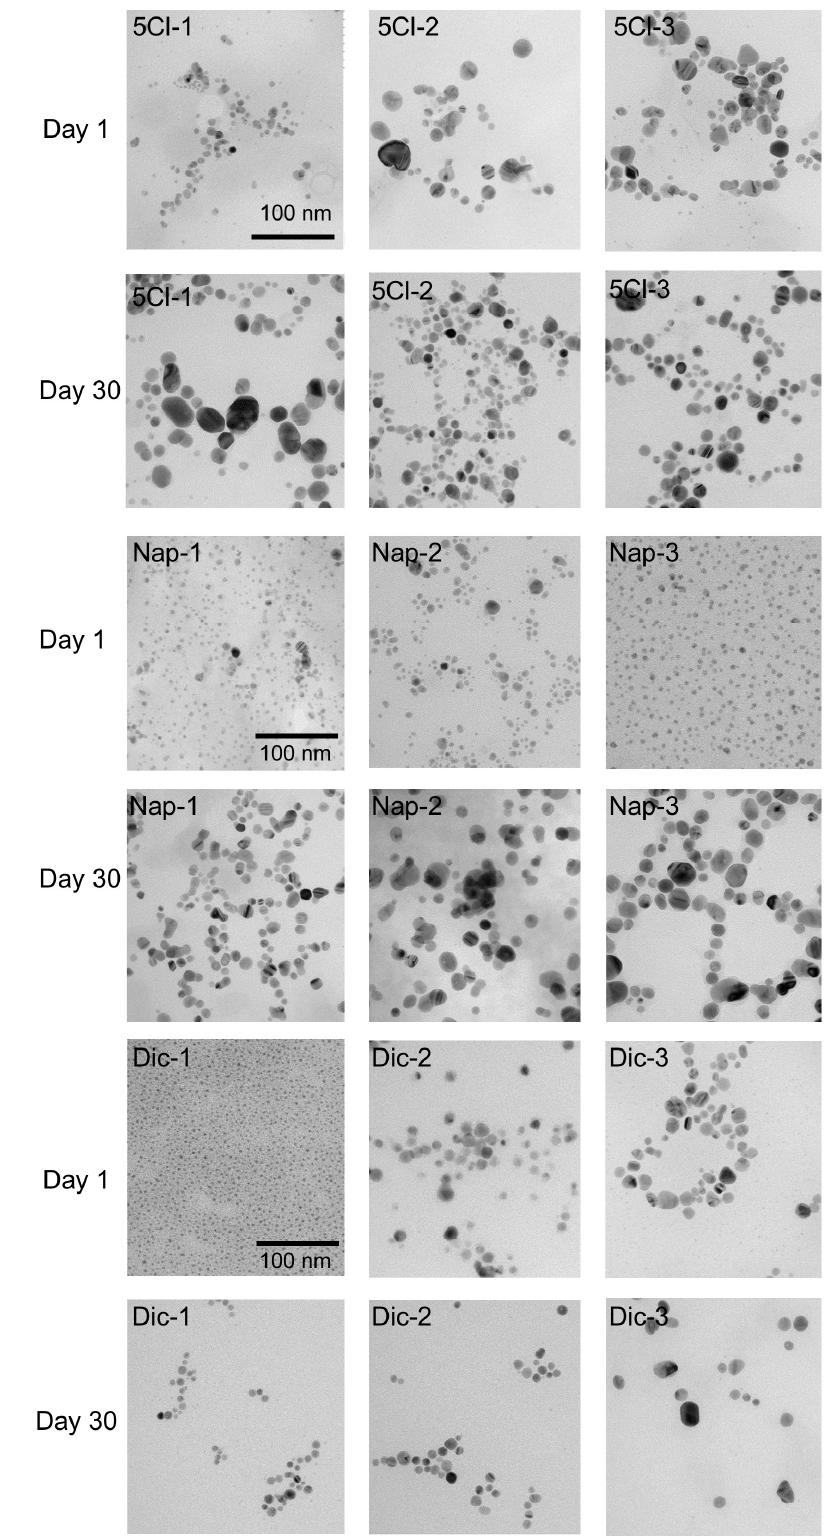
Figure 3. TEM images of the synthesized AgNPs and after 30 days. In the case of AgNP-Dic (2), this phenomenon of size increase was not observed, however, in AgNP-Dic (3) an increase in the size distribution is observed, reaching values of up to 60 nm and also sizes close to 2 nm.